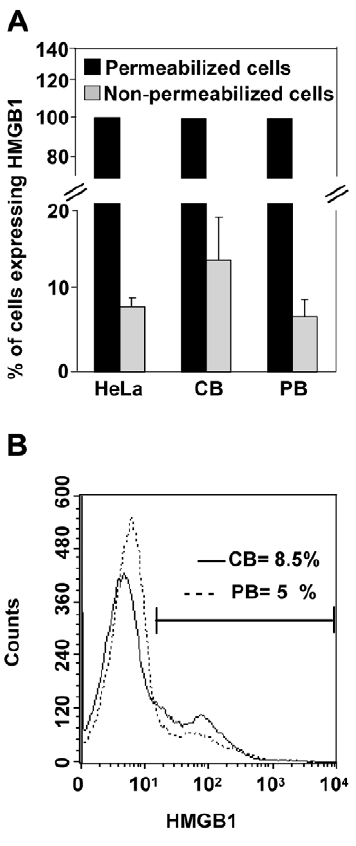
Figure 1. HMGB1 is expressed in human cord blood cells. Mononuclear cells isolated from human cord (CB) and peripheral blood (PB) have been cultured in complete growth medium in absence of external stimuli. (A) The intracellular and surface expression of HMGB1 has been determined 48 h after isolation by flow cytometry analysis in permeabilzed and non-permeabilized cells, respectively. HeLa cells represent the reference cell line known to be HMGB1 positive. Values (mean 6 SD of eight experiments from different donors) are expressed as percentage of cells labeled with anti-HMGB1 antibody. (B) The fluorescence histogram plot derived from FACS analysis shows the HMGB1 expression profile of CB cells (solid line) and PB cells (dotted line). The percentage of HMGB1 positive cells is indicated in graph. The histogram plot is representative of eight different experiments.